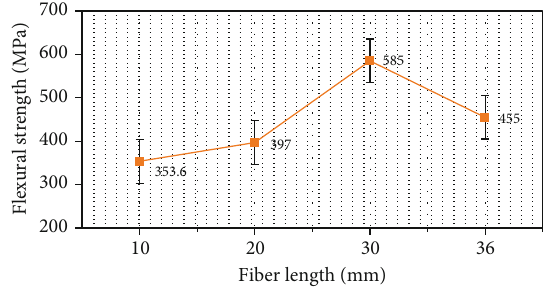
Figure 8: E ff ect of fi ber length on fl exural